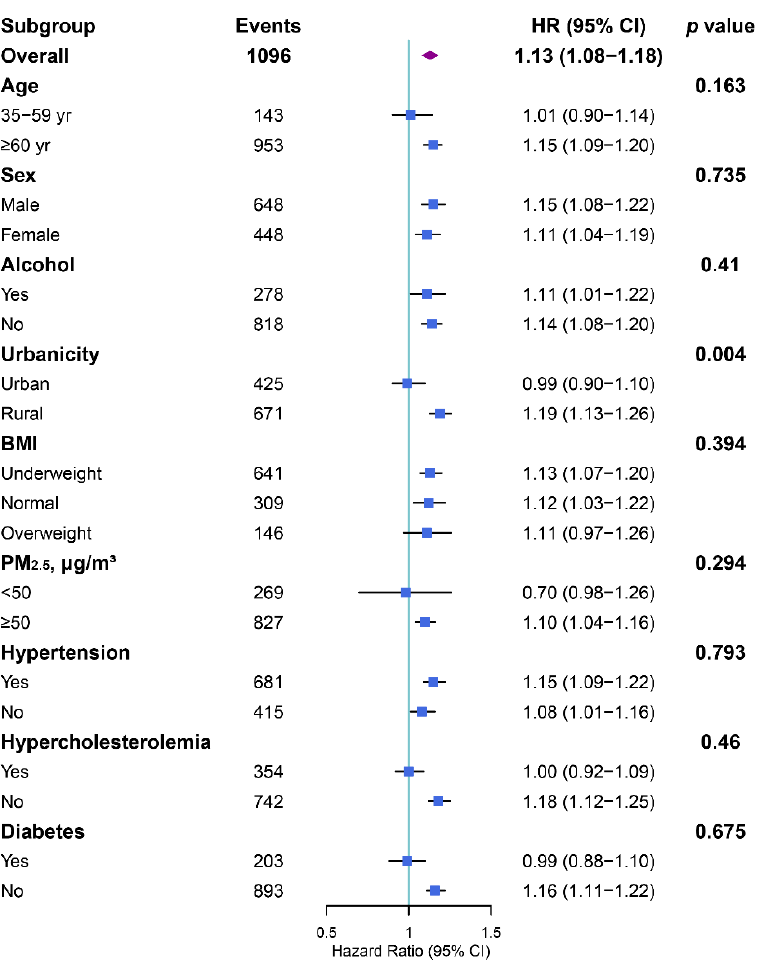
Figure 4. Subgroup analyses of hazard ratios (with 95% CIs) of all-cause mortality associated with a 1 °C increase in annual average DTR exposure. Abbreviations: DTR, diurnal temperature range; BMI, body mass index; PM 2.5 , particles with an aerodynamic diameter of ≤ 2.5 μ m.